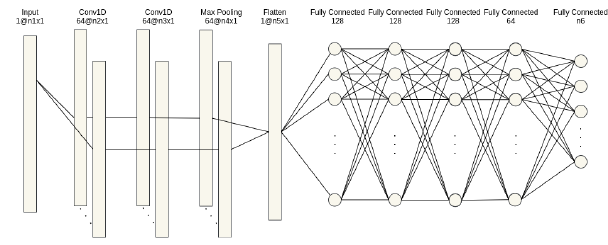
Figure 1. Final CNN architecture for both